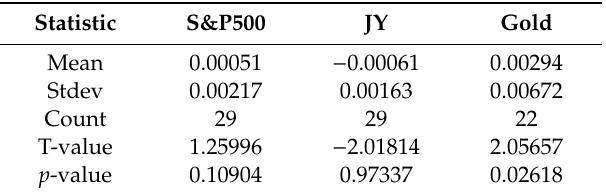
Table 10. The ($) h c-BA ’s HE—the ($) h c ’s